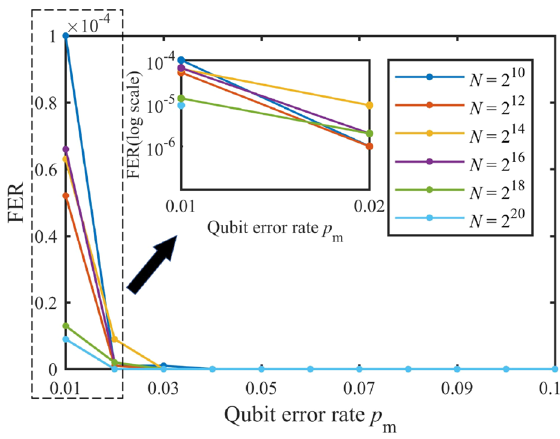
Figure 9. The decoding FER of Bob.